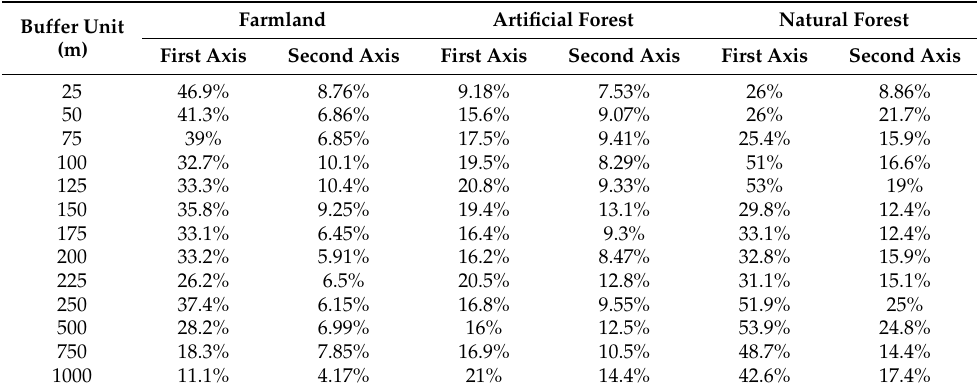
Table 4. Explanation of two axis of RDA analysis under different buffer radius.